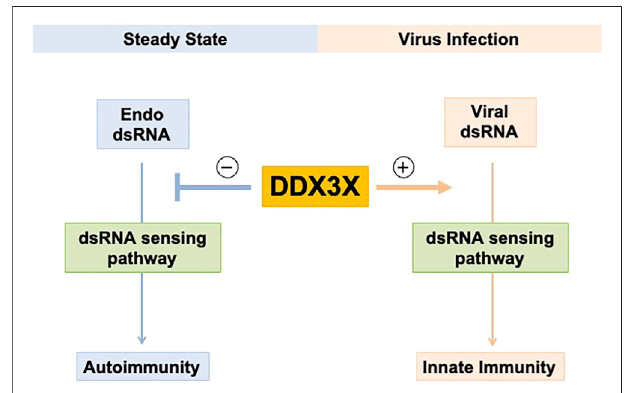
FIGURE 2 | Potential dual role of DDX3X in regulating dsRNAs and innate immunity. DDX3X promotes innate antiviral immunity by activating the dsRNA-sensing pathway and type I IFN production upon viral infection and exogenous dsRNA stimulation. DDX3X is involved in